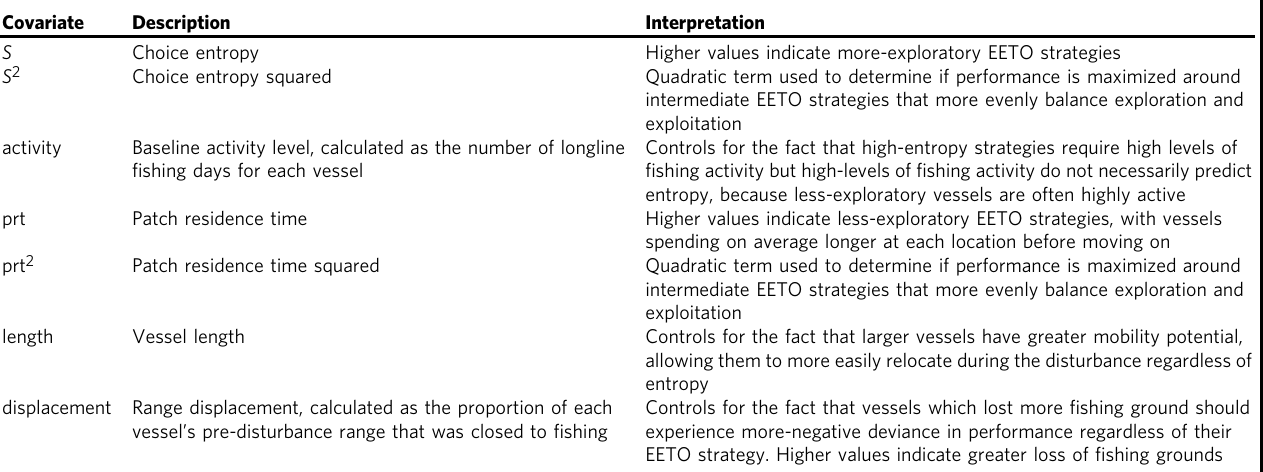
Table 1 Covariates used to investigate relationships between exploration and performance prior to and during the spatial closure of Gulf of Mexico longline fi shing grounds in